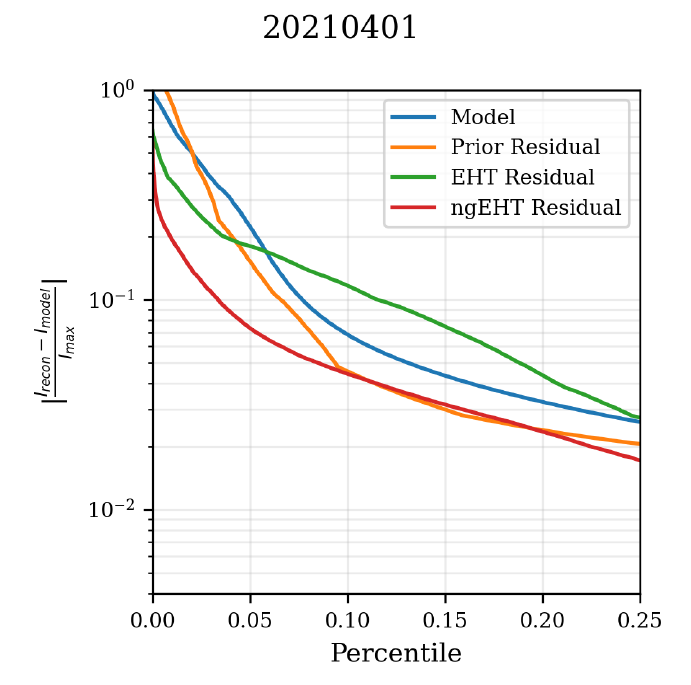
Figure 13. Same as Figure 12, but for SgrA* snapshot imaging. Note that the y-axis (residual noise) has a different range than the M87 one to highlight the range of interest for the different imaging scenarios (full track vs.